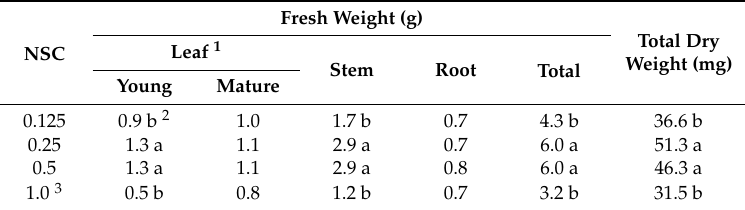
Table 1. Effects of nutrient solution concentration (NSC) on fresh and dry weights of Ophiorrhiza pumila at 63 days after start of the treatment (DAT) in experiment 1 ( n = 8).